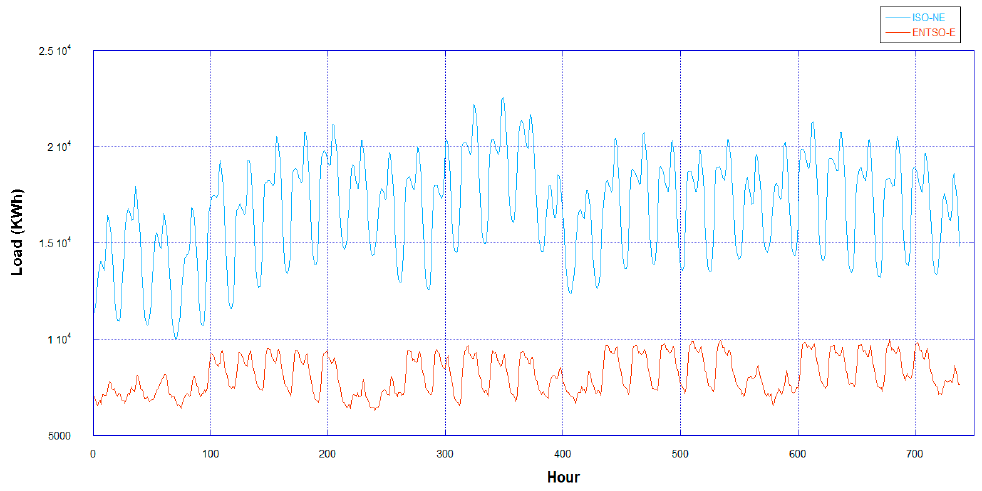
Figure 3. Load demand trend over a year.